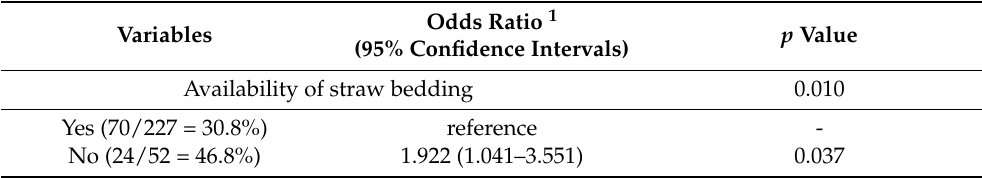
Table 5. The results of the multivariable analysis for a high proportion (>63%) of Teladorsagia spp. among Trichostrongylidae helminths in faecal samples from 279 sheep flocks in a countrywide investigation in Greece.